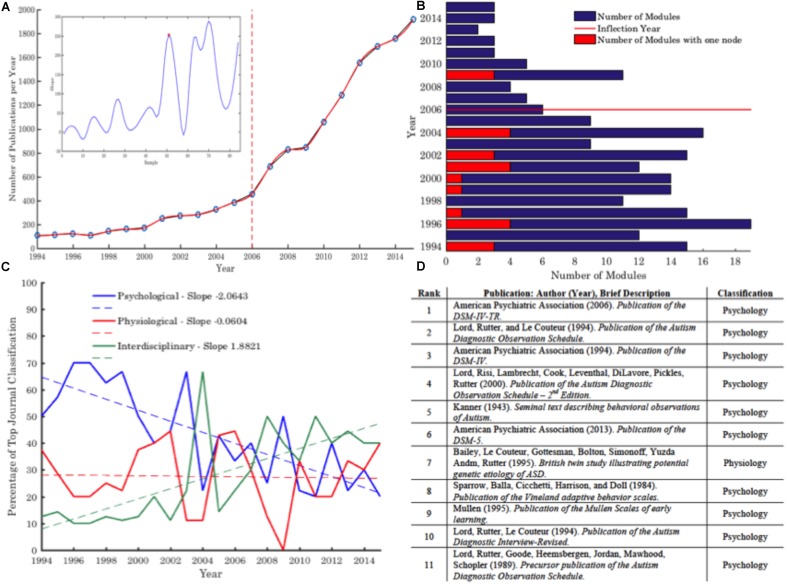
(A) Trend analysis of the number of publications under the topic ‘Autism’ per year, and the critical inflection year highlighted (Slope = Δy/Δx; see inset a). (B) Overview of the number of self-clustered modules identified across the corpus (see section “Keyword Co-occurrence and Modularity: Research Themes – Evolution and Cross Talk”). A number of yearly modules include a single keyword—these are indicated in red. (C) Most frequently occurring journals for publication per year as categorized into broad thematic silos: Psychological, Physiological and Interdisciplinary, and related empirically estimated trend lines. (D) Classification of top cited publications across the corpus 1994–2015 demonstrates the prevalence of Psychological research and tools. See Supplementary Tables 1–3 for further information on this classification trend as decomposed to the decade level. For larger high resolution figures please see https://figshare.com/s/5210439deb5a6ba0bcf2.